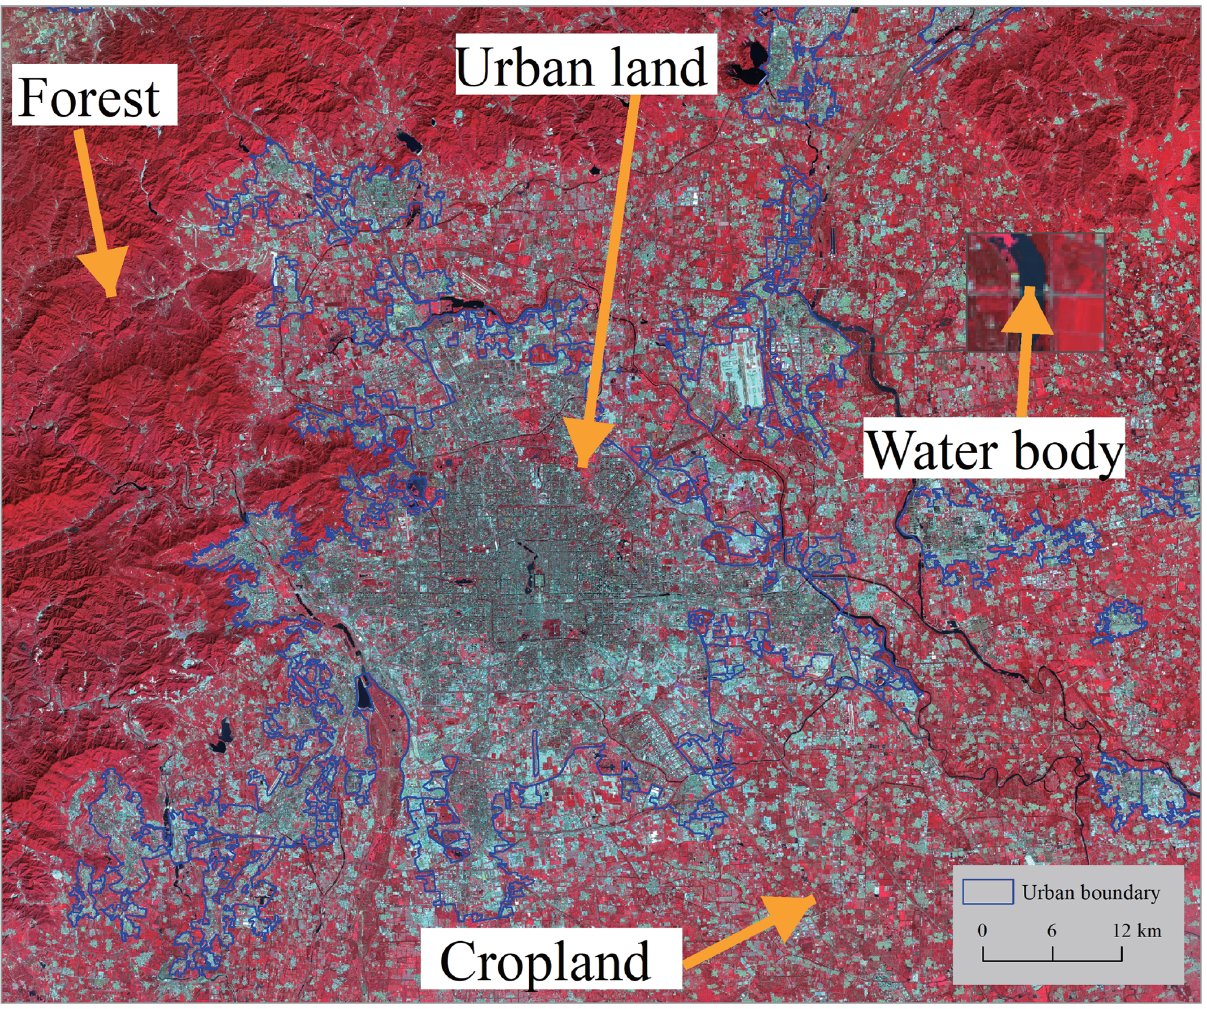
Figure 2. The interpretation symbols and extracted urban boundaries from Landsat images in Beijing city. The images were provided by the Geospatial Data Cloud site, Computer Network Information Center, Chinese Academy of Sciences (http://www.gscloud.cn, last access: 27 September